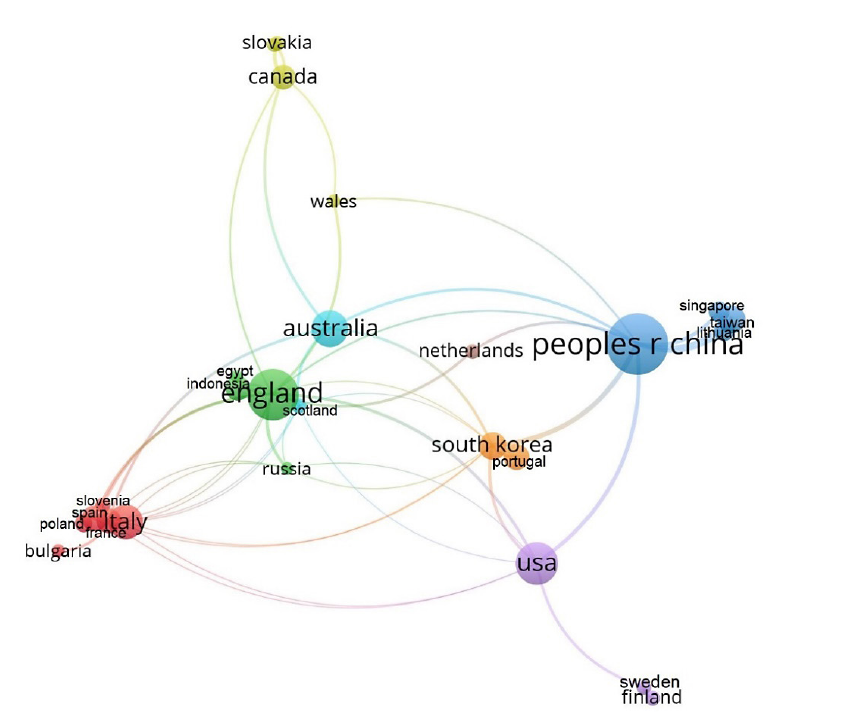
Figure 4. Co-authorship of countries (source: created by the